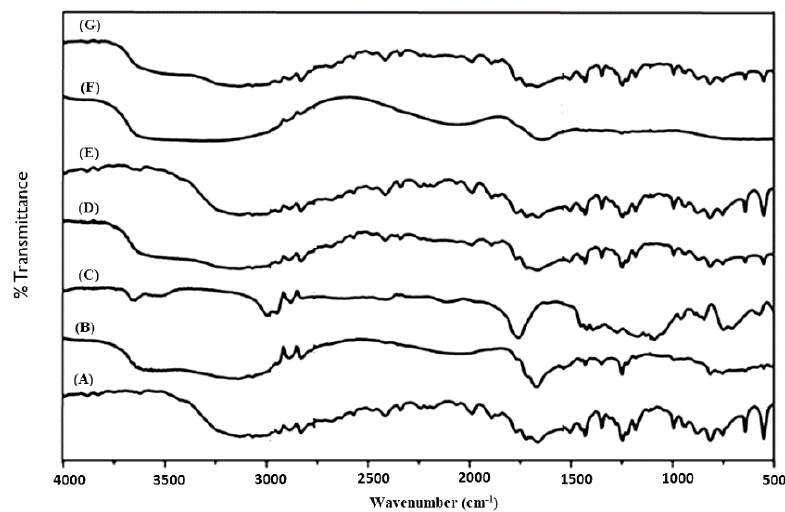
Figure 3. Fourier transform infrared (FTIR) plot from top to bottom ( A ) 5-FU, (B) F9 gold nanoparticles (Placebo 5), ( C ) F10 gold nanoparticles CGP (Placebo 6), ( D ) F11 as 5-CGP (500 mg/mL), ( E ) F12 as 5-GP, ( F ) BSA-HAu mixture and ( G ) F15 as 5-CGP (250 mg/mL).